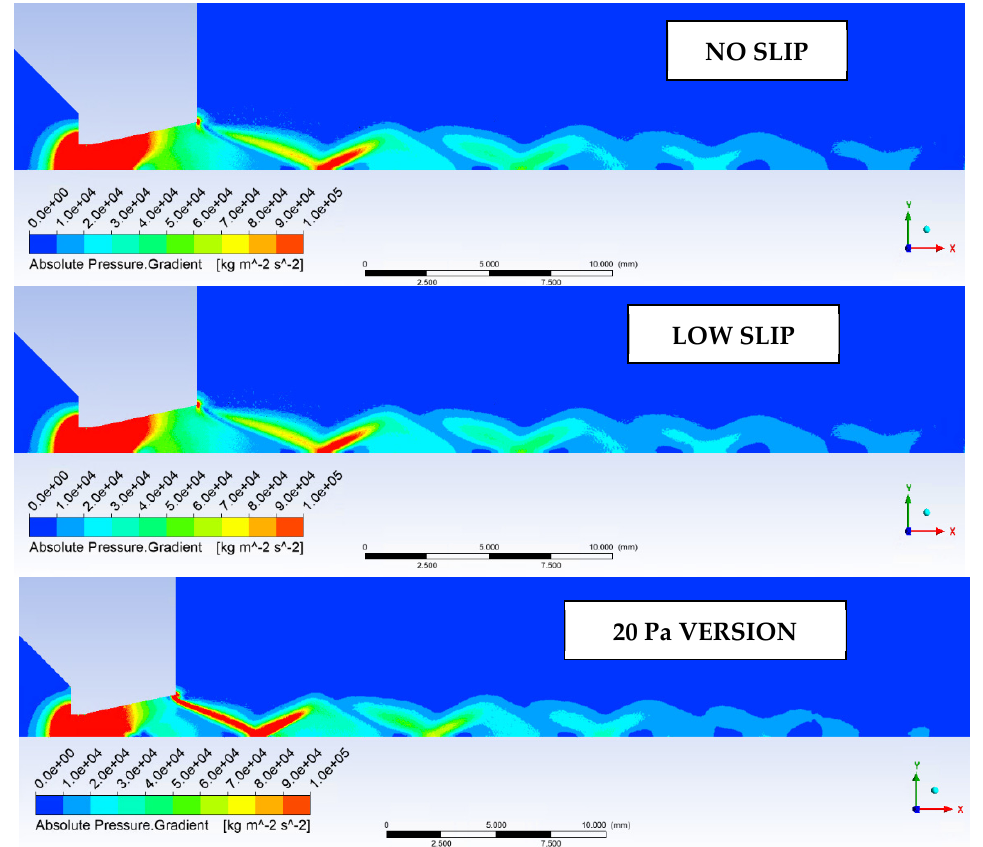
Figure 26. Pressure gradient distribution in the experimental chamber.